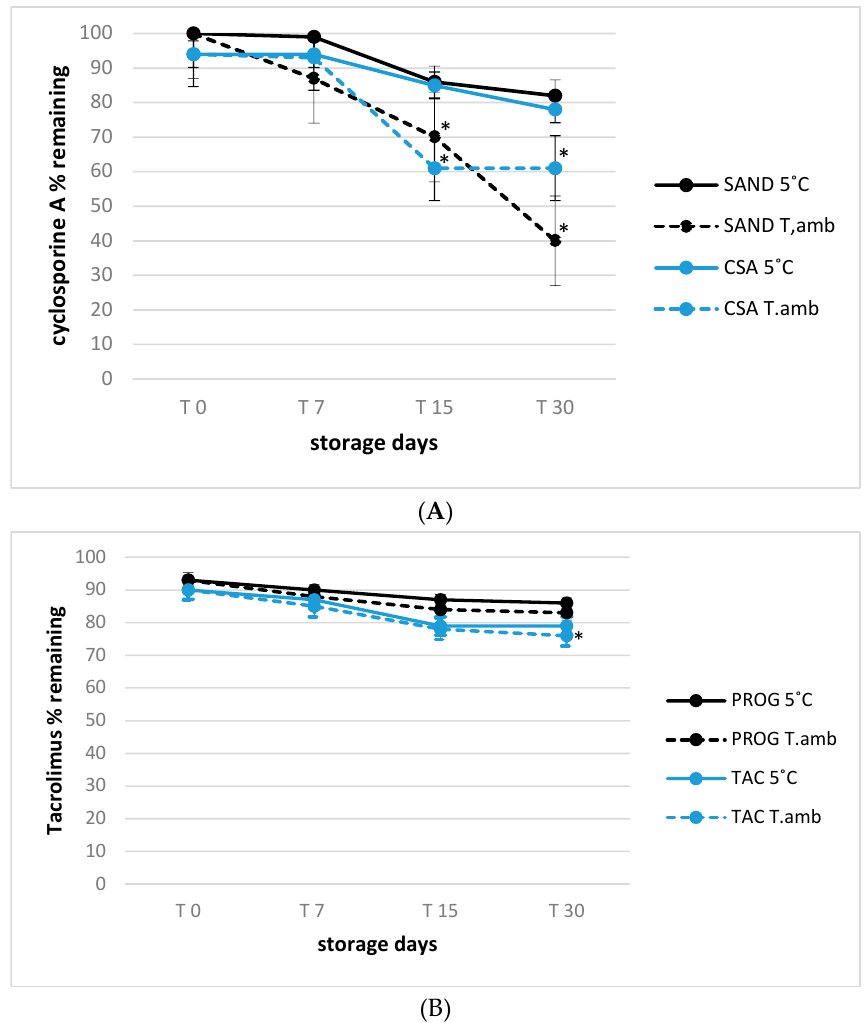
Figure 4. ( A ) 1.0% cyclosporine A formulations stability for 30 days shelf-life after 30 days unopened storage; * p < 0.05, T.amb versus 5 °C storage temperature. ( B ) 0.1% tacrolimus formulations stability for 30 days shelf-life after 30 days unopened storage; * p < 0.05, T.amb versus 5 °C storage temperature.